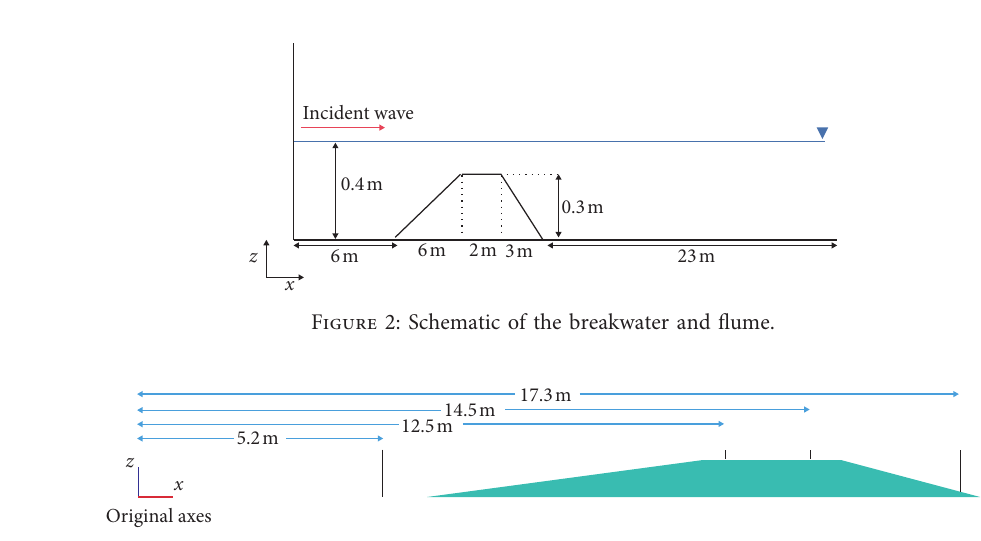
Figure 3: Positions of the sensors for measuring the free surface elevation. Table 1: Mesh sizes of the applied